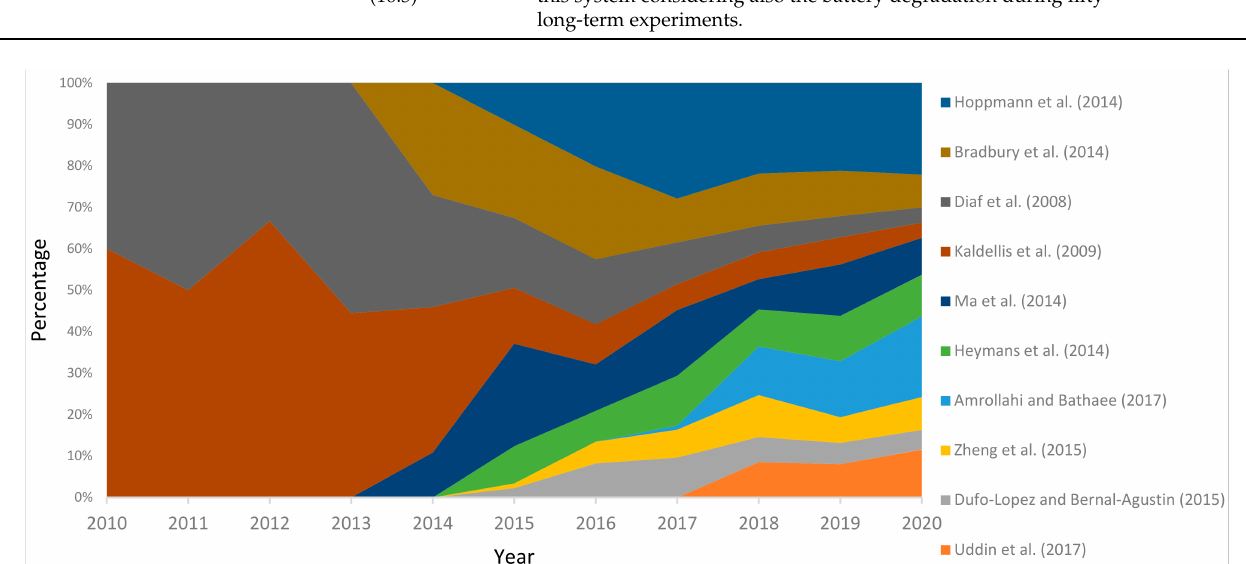
Figure 6. Distribution of citations of most cited